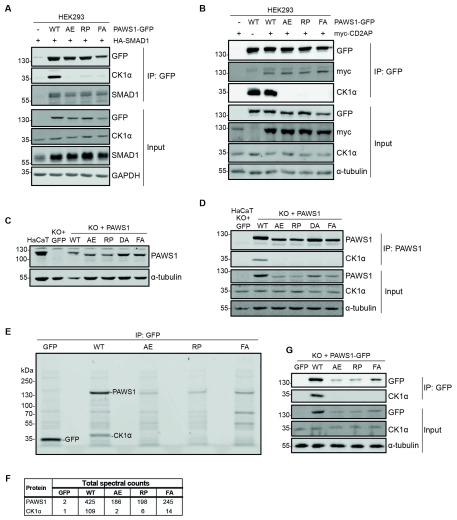
Pathogenic PPK point-mutations in PAWS1 disrupt its interaction with CK1α.
A,
B: HEK293 cells transiently expressing PAWS1-GFP and HA-SMAD1 (
A) or myc-CD2AP (
B) were subject to GFP immunoprecipitation (IP) and immunoblotting (IB) for the indicated proteins.
C: Using retroviral transduction, PAWS1 or the indicated mutants were stably re-expressed in HaCaT PAWS1
−/− (KO) cells; GFP control, wildtype (WT), A34E (AE), R52P (RP), D262A (DA), F296A (FA). Cell extracts were analysed by IB.
D: Immunoprecipitation of PAWS1 was performed from HaCaT cells described in (
C).
E–
G: PAWS1-GFP or the indicated mutants were stably expressed in PAWS1-KO HaCaT cells as described in (
C), and immunoprecipitated with GFP-Trap beads. GFP IP samples were separated by SDS-PAGE and Coomassie stained (
E). Each lane was cut into 6 pieces and subsequently processed for protein identification by mass spectrometry. Table showing total spectral counts for PAWS1 and CK1α (
F). Input and IP samples were analysed by IB with the indicated antibodies (
G).